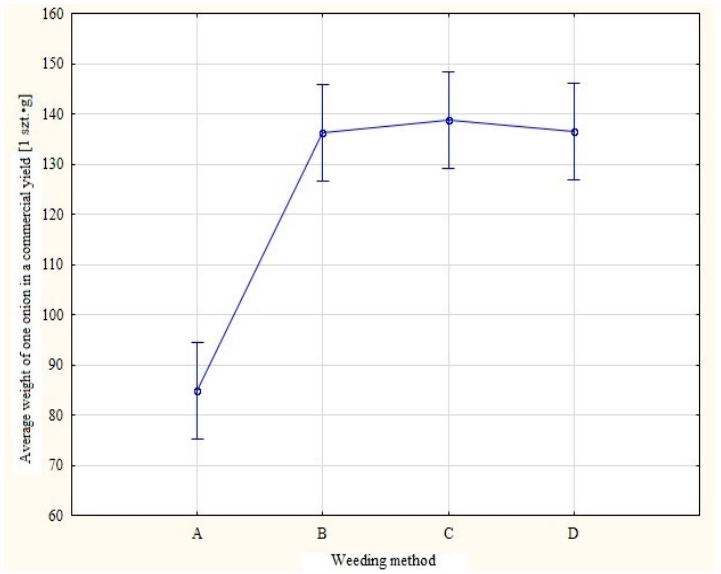
Figure 16. Expected marginal averages for 0.95 confidence intervals for the average weight of one onion in the commercial yield in 2016 (source: own work).